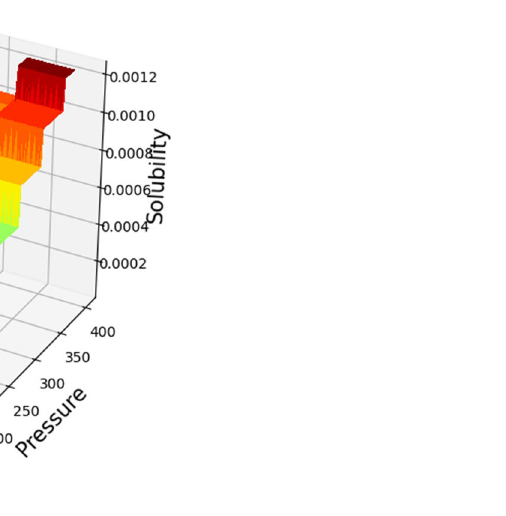
Figure 6. Input–output projection